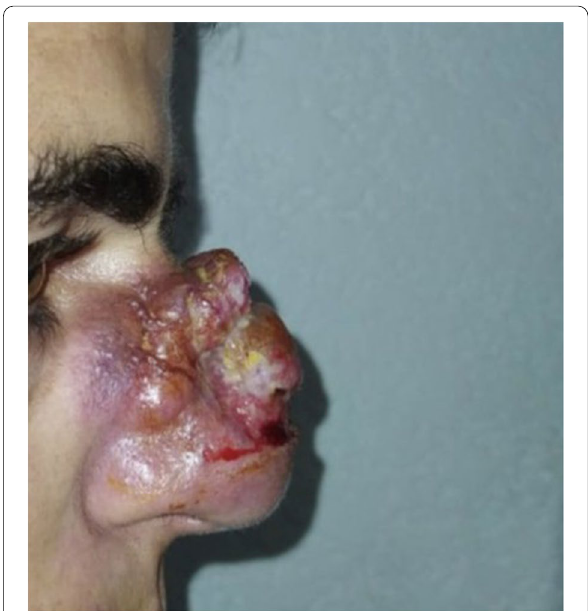
Fig. 1 Patient’s photo showing 5cm large tumor of the dorsum nasi involving the right paranasal region